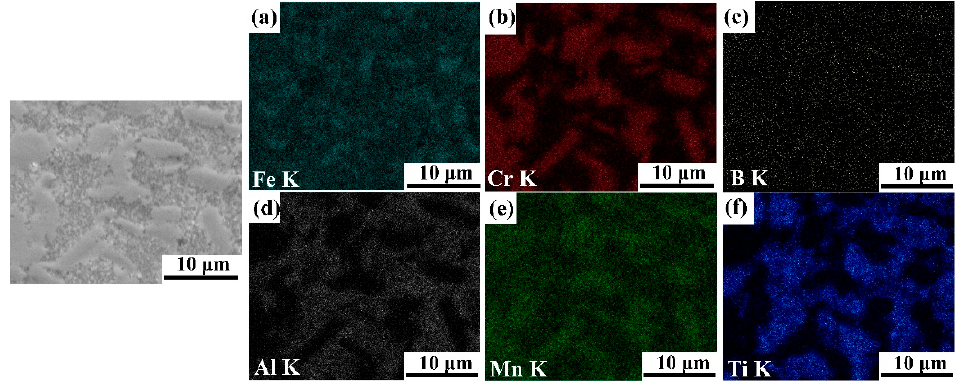
Figure 3. SEM image of 15 vol.%TiB 2 /Fe-15Cr-10Mn-5Al composite and elemental maps showing the distribution of ( a ) Fe, ( b ) Cr, ( c ) B, ( d ) Al, ( e ) Mn, and ( f ) Ti.